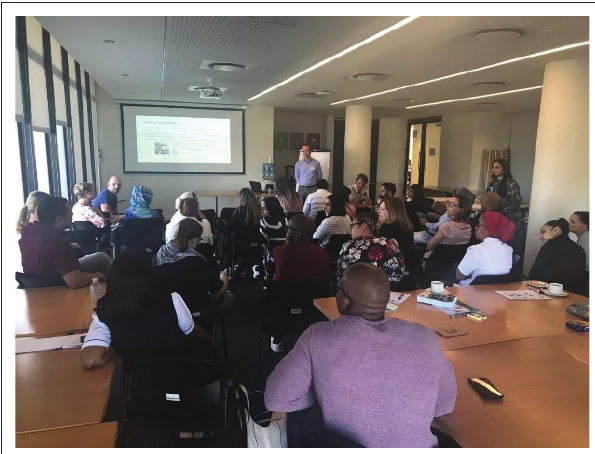
FIGURE 1: Local collaborators from the Western Cape Department of Health.